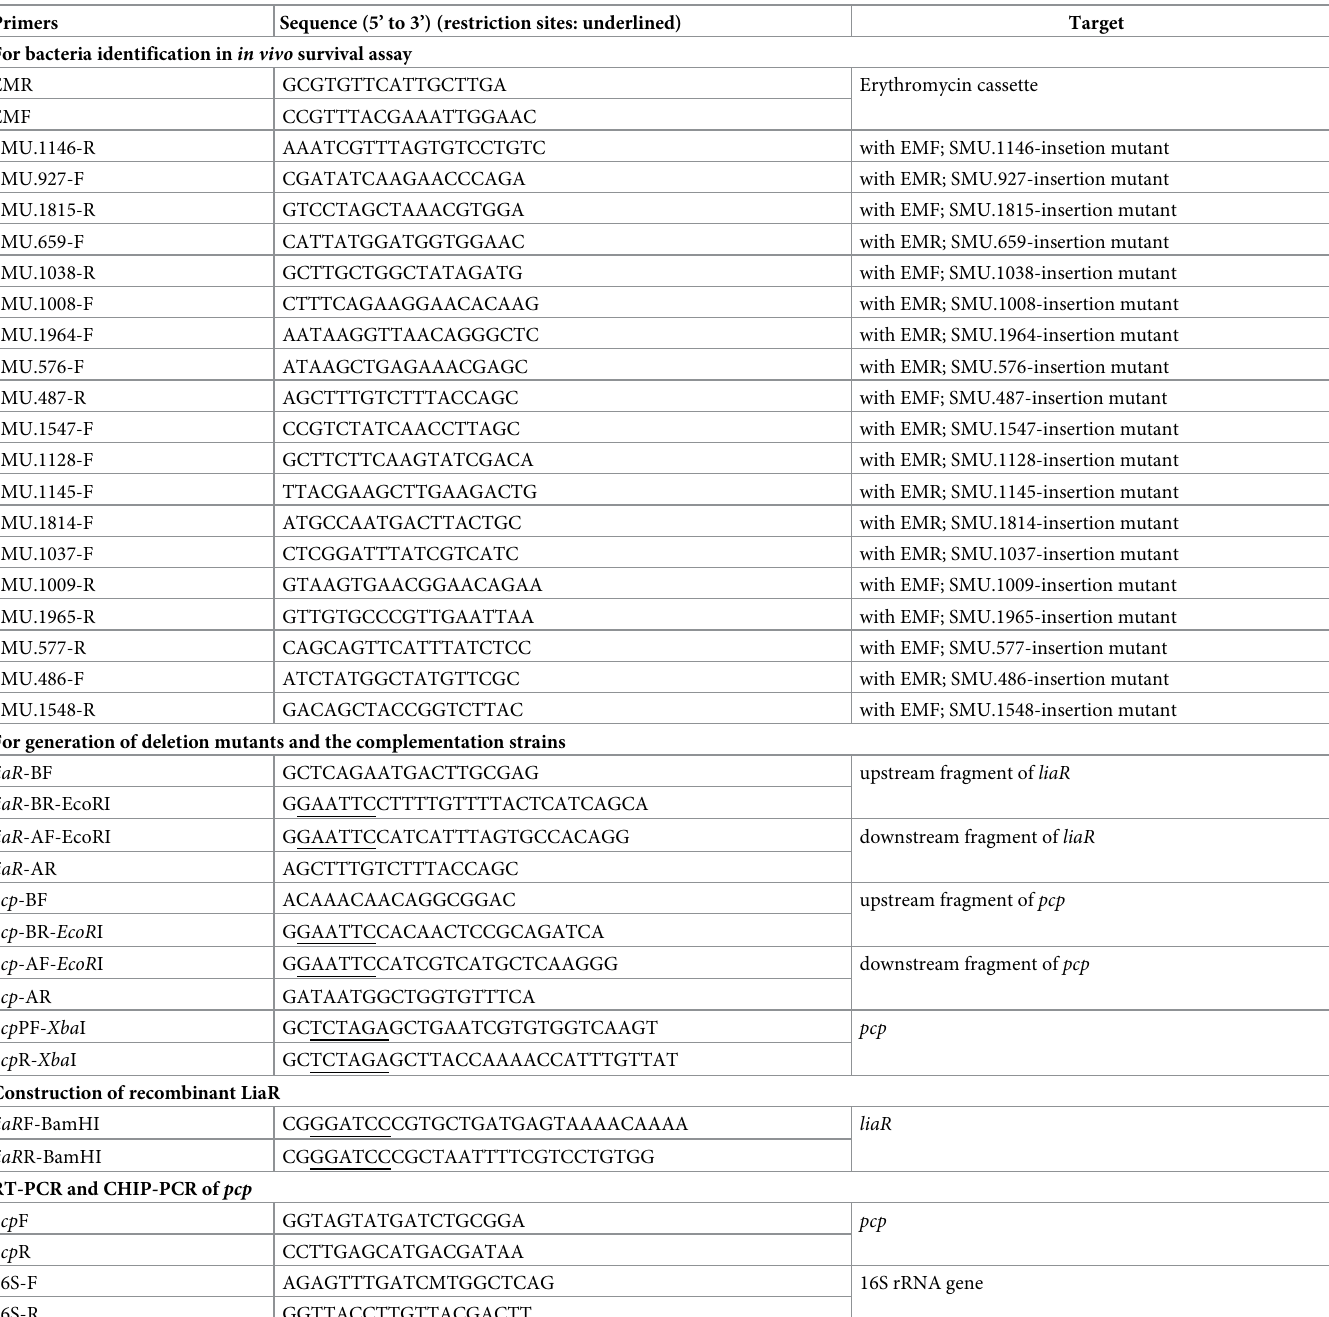
Table 1. PCR primers used in the current